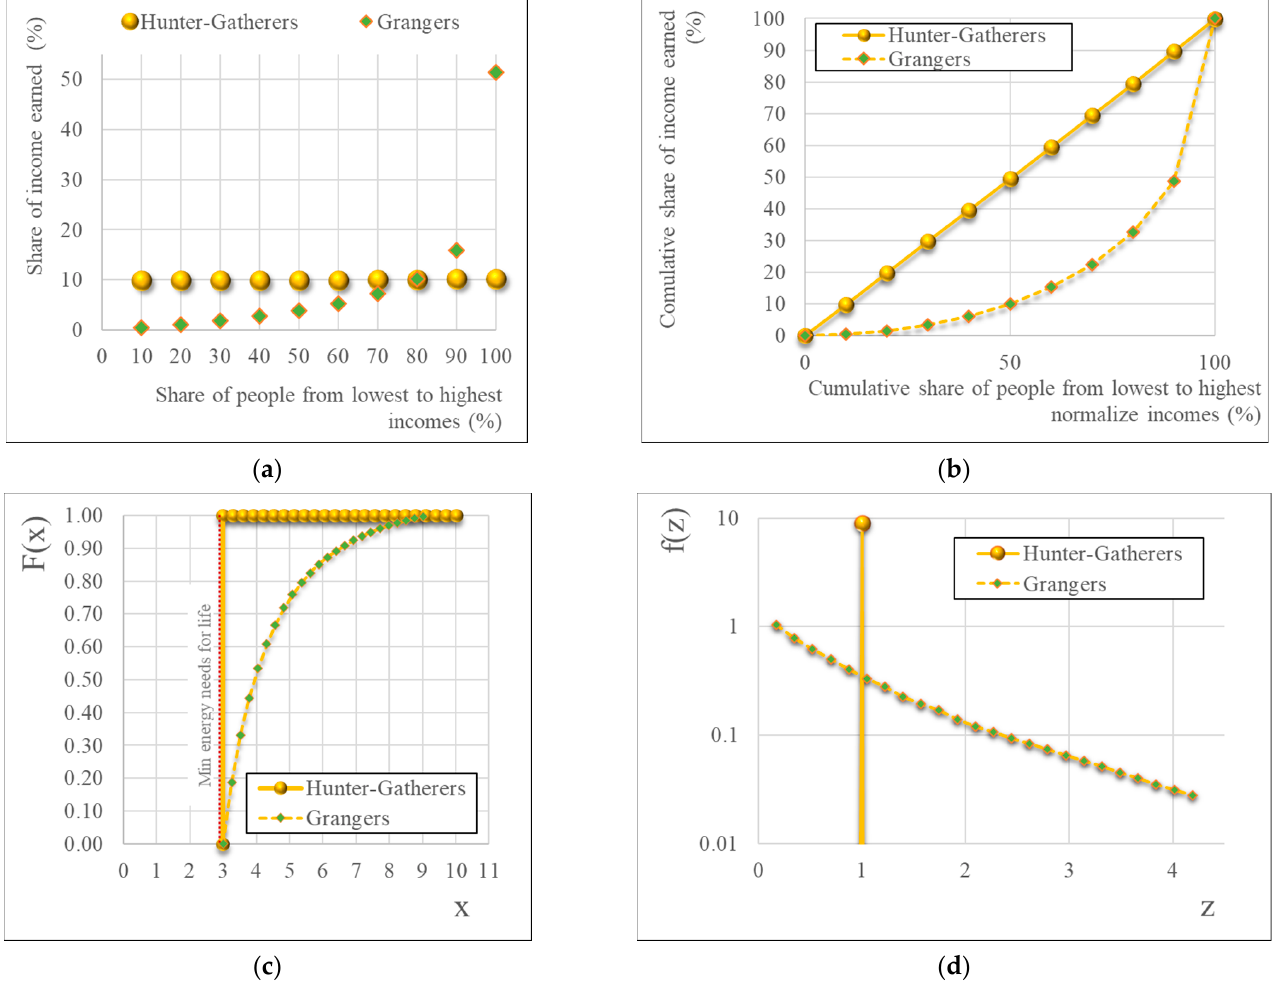
Figure 10. ( a ) Share of wealth, using energy as a proxy, in the Hunter-Gatherers and granger’s society; ( b ) Lorenz curve. ( c ) Probability distribution function of energy. ( d ) Probability density function of the standardized energy.